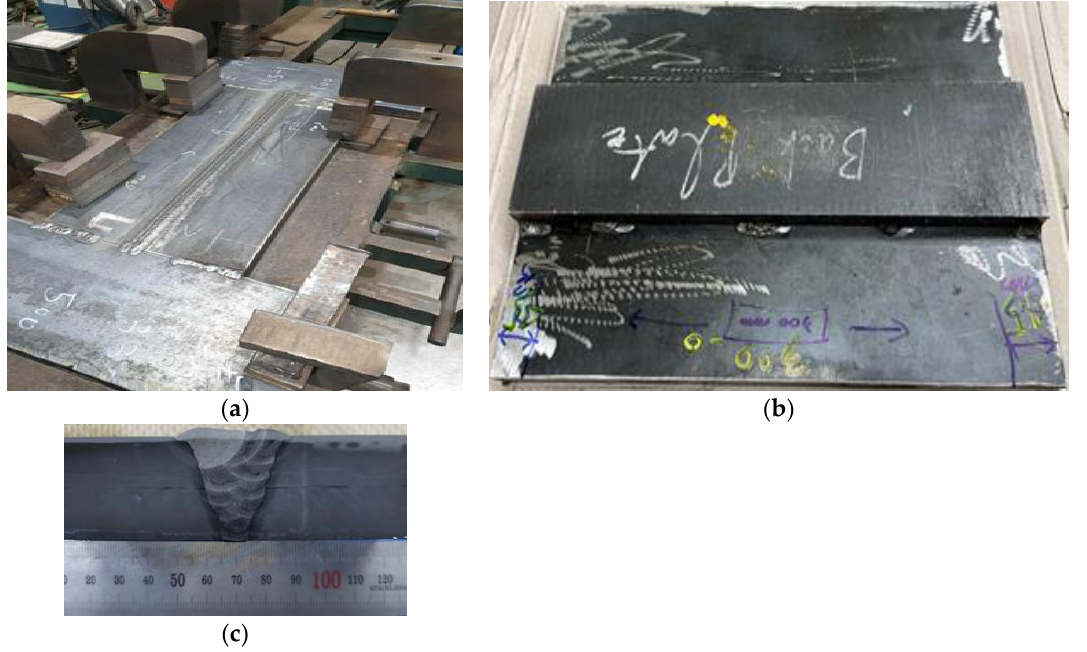
Figure 2. Constrained condition of the specimens. ( a ) Jig and end tap; ( b ) steel backing; ( c ) macro section.